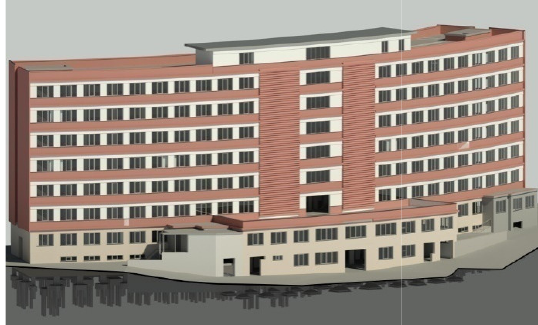
Figure 15: View of the rear of the